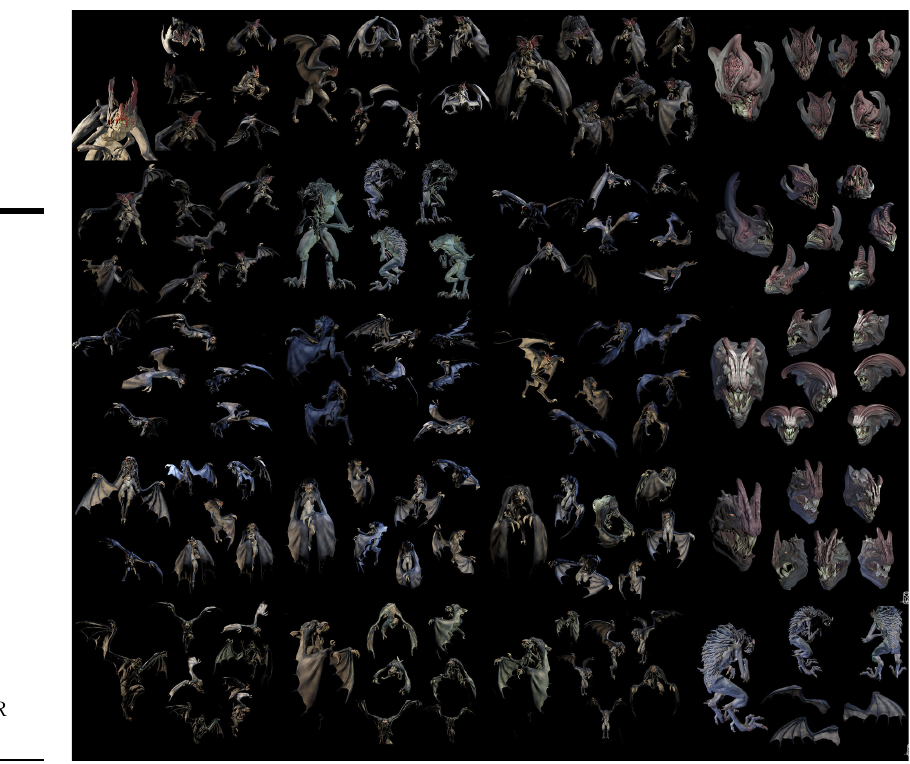
Figure 6. Contact sheet of designs from the example using VR